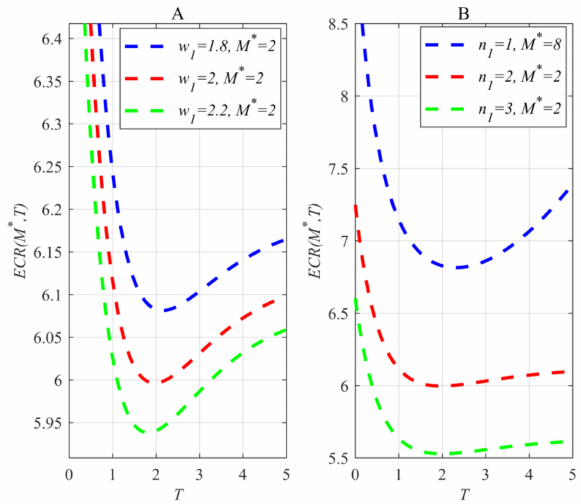
Figure 5. The effect of n 3 and w 3 on the optimal